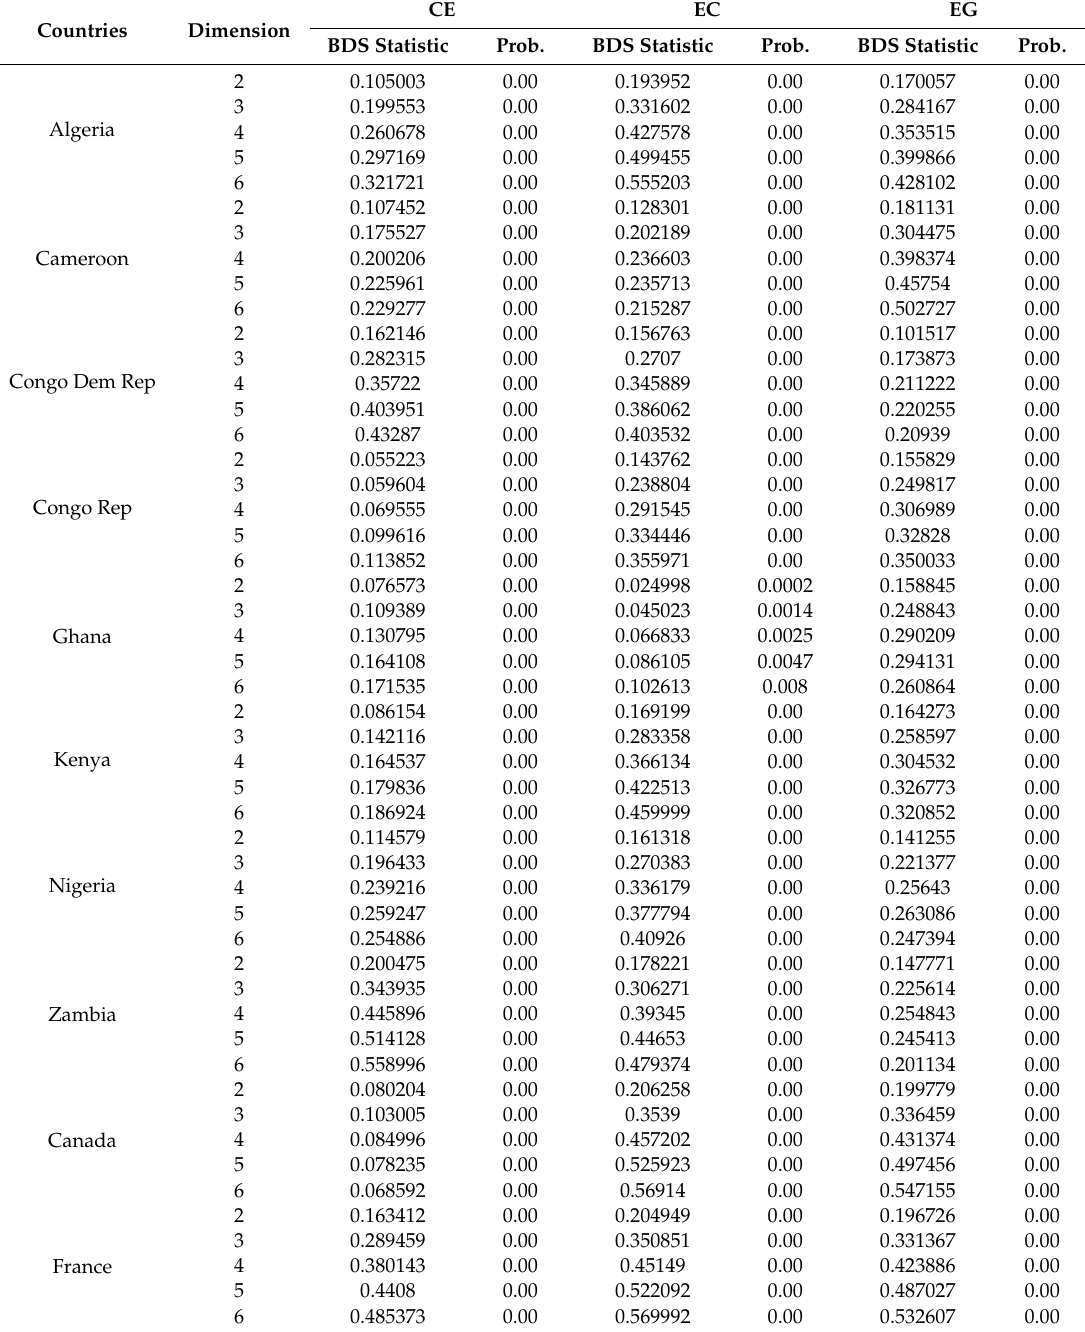
Table 6. BDS Test